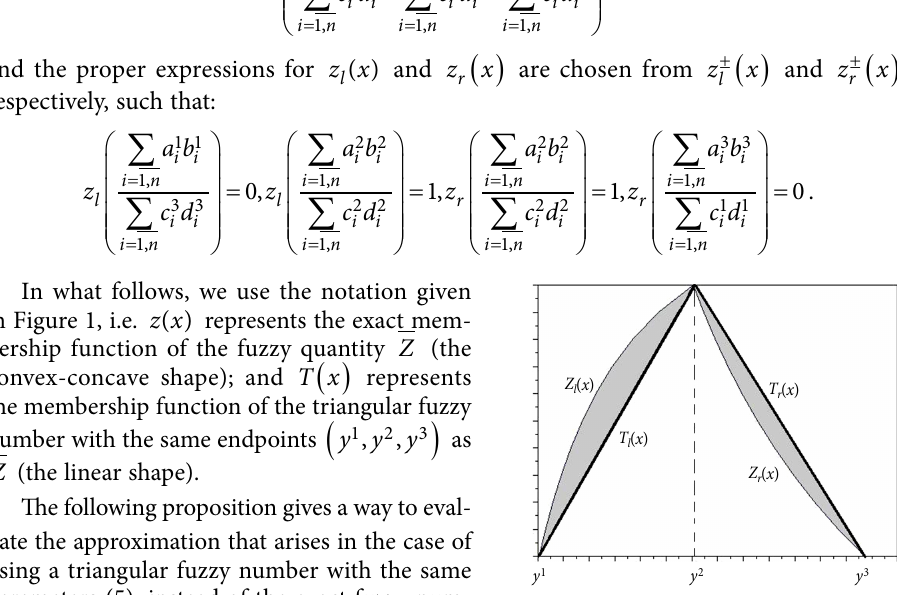
Fig. 1. The graph of the exact membership function of Z , and its approximation by a triangular